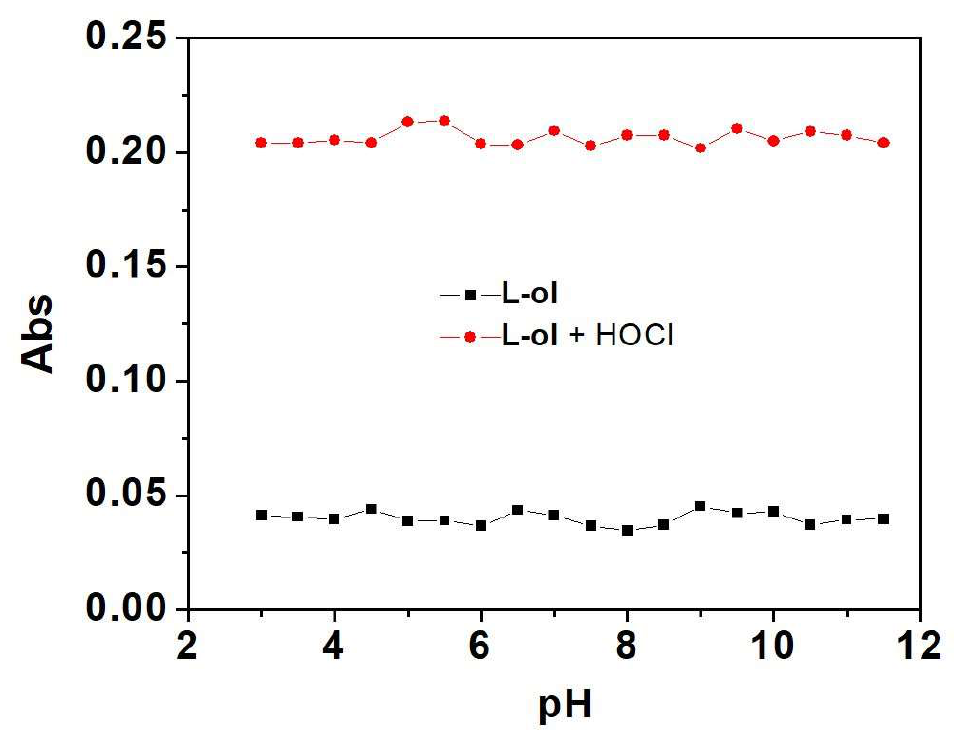
Figure 8. Effect of pH on the absorbance of L-ol (10 μM) at 619 nm in the absence and presence of HOCl (50 μM).